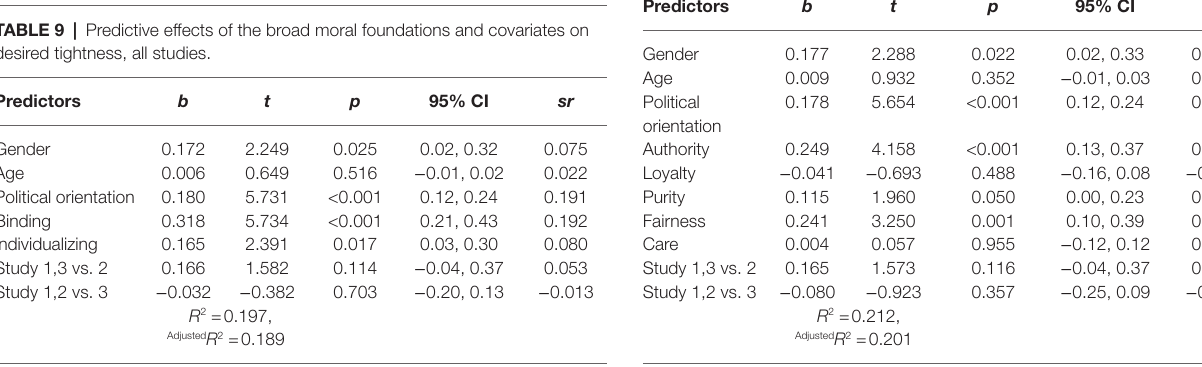
TABLE 10 | Predictive effects of the five moral foundations and covariates on desired tightness, all studies.